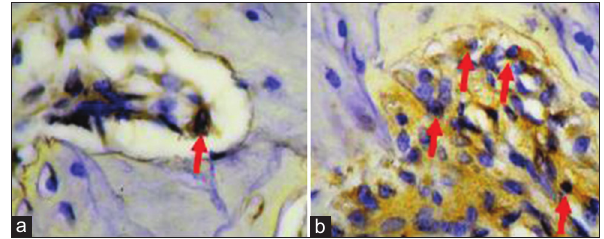
a Figure-2: Platelet-derived growth factor expressions in the control group (a) and in the treatment group (b). Table-1: Mean and standard deviations of VEGF and PDGF expressions in the control group and the treatment group. Group N